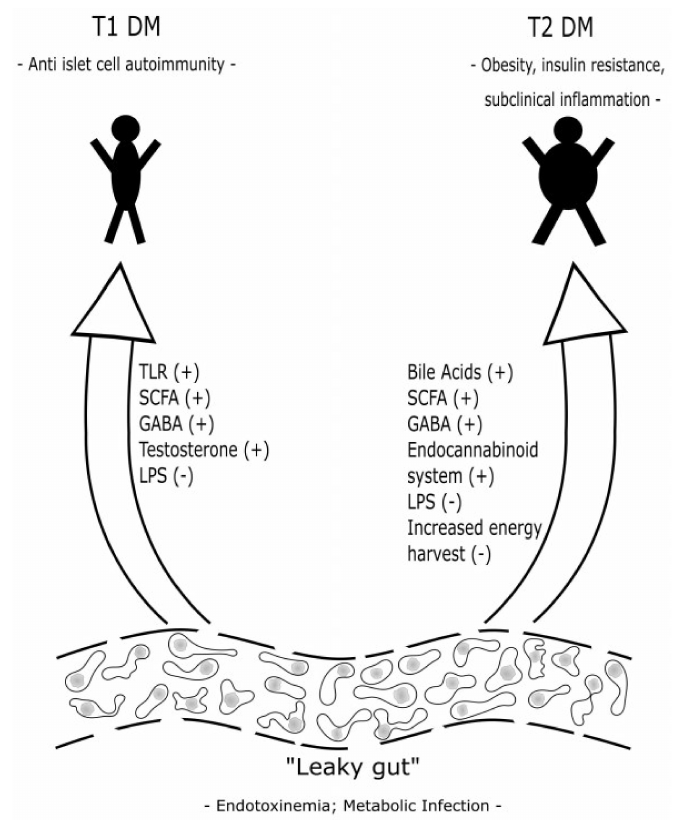
Figure 2. Putative factors in the interaction between gut microbiota and their impact on diabetes mellitus (+: positive; − : negative). Please note that most mechanisms have not been demonstrated in animal models yet. Abbreviations: SCFA: Short-chain fatty acids; GABA: Gamma-aminobutyric acid; TLR: Toll-like receptors; LPS: